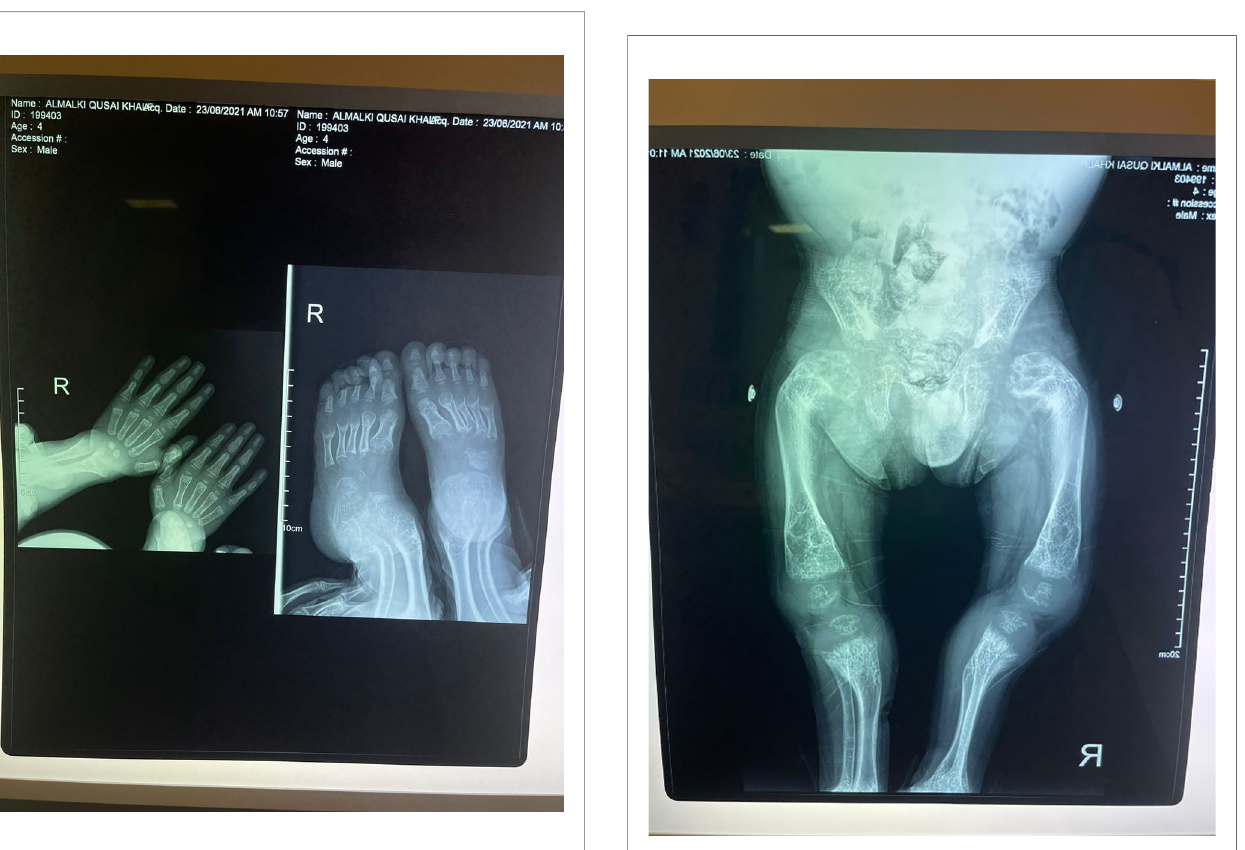
FIGURE 4 | Fraying, splaying, widening and cupping of the metaphyseal endplates of upper and lower limb bones. FIGURE 5 | Marked bowing of both femurs and